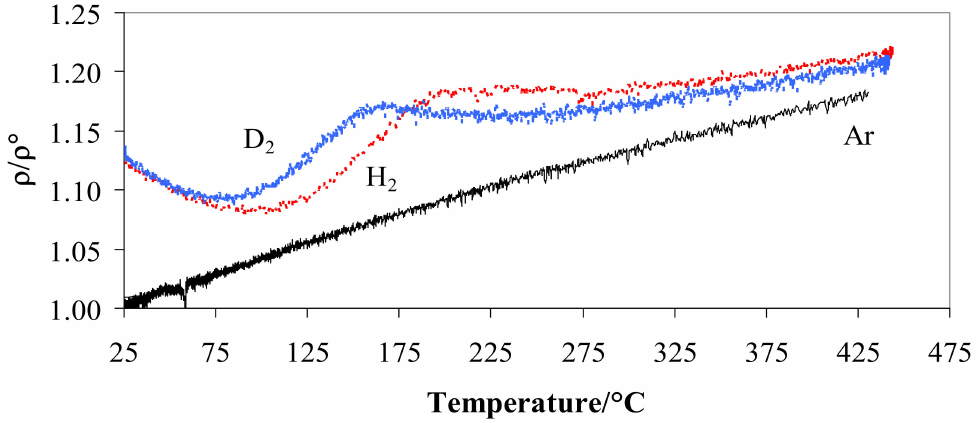
Figure 3. Ratio ρ / ρ ◦ vs. temperature for Pd-Ag 21 wt.% in pure hydrogen, deuterium, or argon at 100